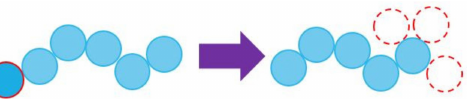
Figure 1. Schematic of the reptation move implemented through a configurational bias pattern with n trials = 3. Different candidate positions could be picked by the selection of the bond length, bending, and torsion angles used for the re-construction of the